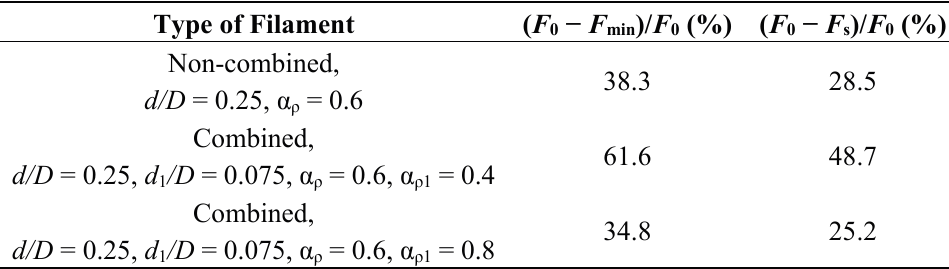
Figure 12. Dynamics of front drag force for different α ρ 1 ; α ρ = 0.6. Table 5. Pointed body. M = 1.89.